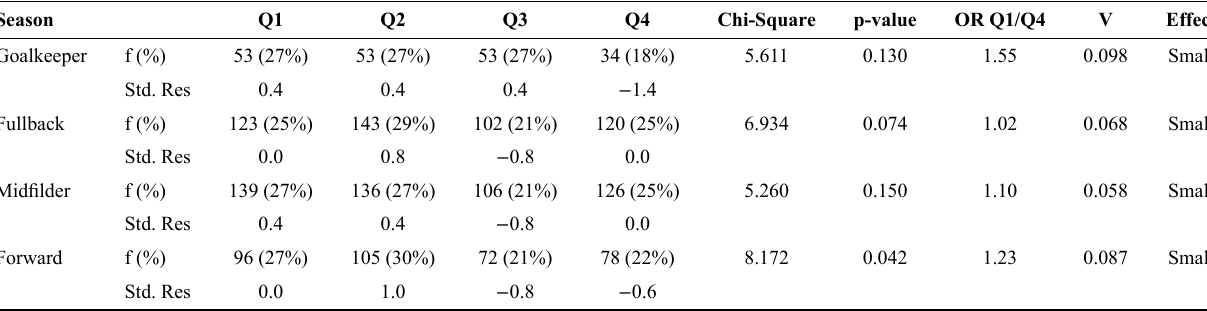
Table 3 - Distribution of the birth months by playing position in all Olympic Games (1996-2016). Season Q1 Q2 Q3 Std. Res Std.